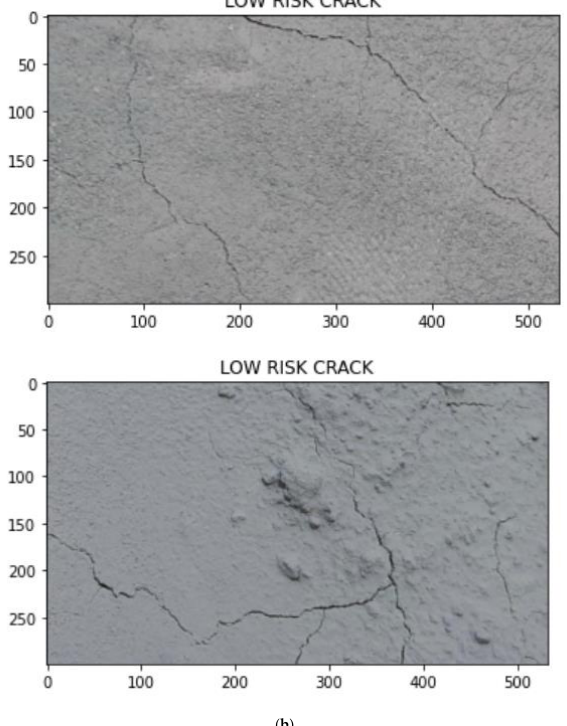
Sensors 2023 , 23 , x FOR PEER REVIEW Figure 12. ( a , b ) Sample output images from the model classified as “Low -Risk C rack” for field images. Figure 12. ( a , b ) Sample output images from the model classified as “Low-Risk Crack” for field images.